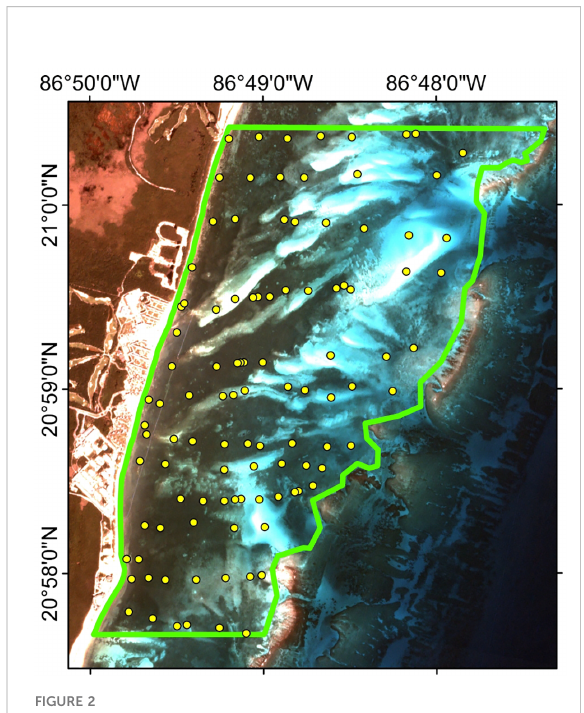
FIGURE 2 Location of the 105 points sampled to obtain ground truth data (between April 3 rd and June 2 nd , 2021) to be used as seed pixels in supervised classi fi